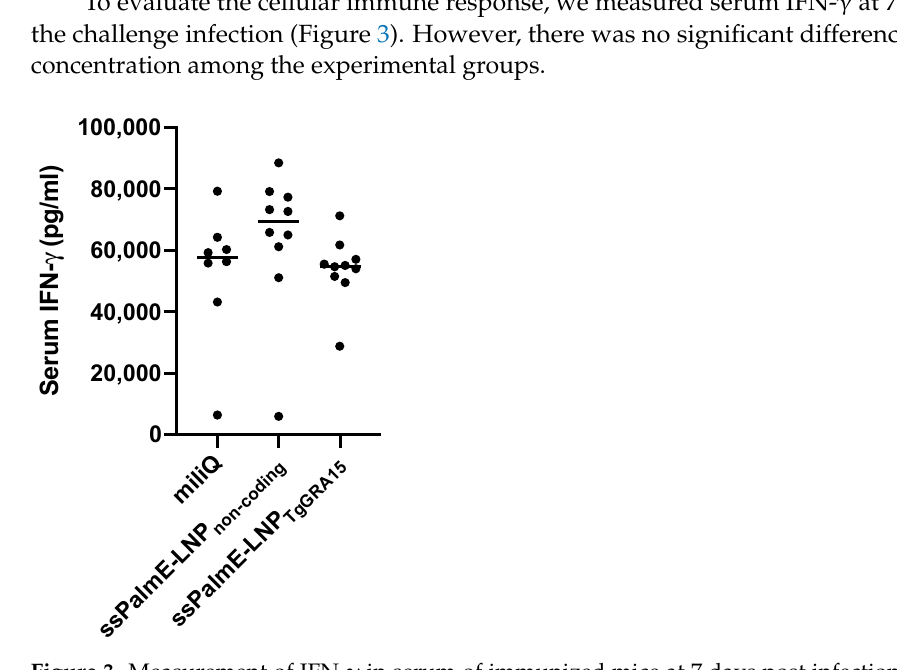
Figure 2. TgGRA15-specific antibody responses of immunized mice. ( a ) Sera from mice immunized with ssPalmE-LNP TgGRA15 ( n = 10), ssPalmE-LNP non-coding ( n = 10), or Milli-Q water ( n = 8) were analyzed using ELISAs to detect TgGRA15-specific total IgG in the sera. ( b ) Analysis of TgGRA15-specific IgG1 and IgG2c antibodies in the sera from mice immunized with ssPalmE-LNP TgGRA15 ( n = 10). The values are expressed as optical densities at 415 nm. Each bar represents the mean ± SD. (*) significant differences of the same day ( a ) and same antibody subclass ( b ), which were determined by one-way ANOVA and a Tukey post hoc test (* p < 0.05).